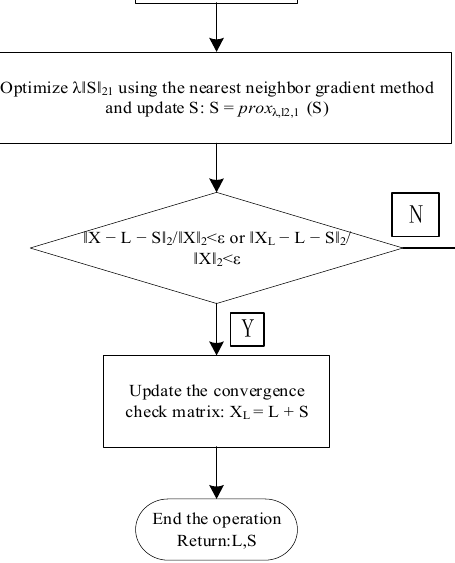
Figure 7. The flow chart of the algorithm based on ADMM.